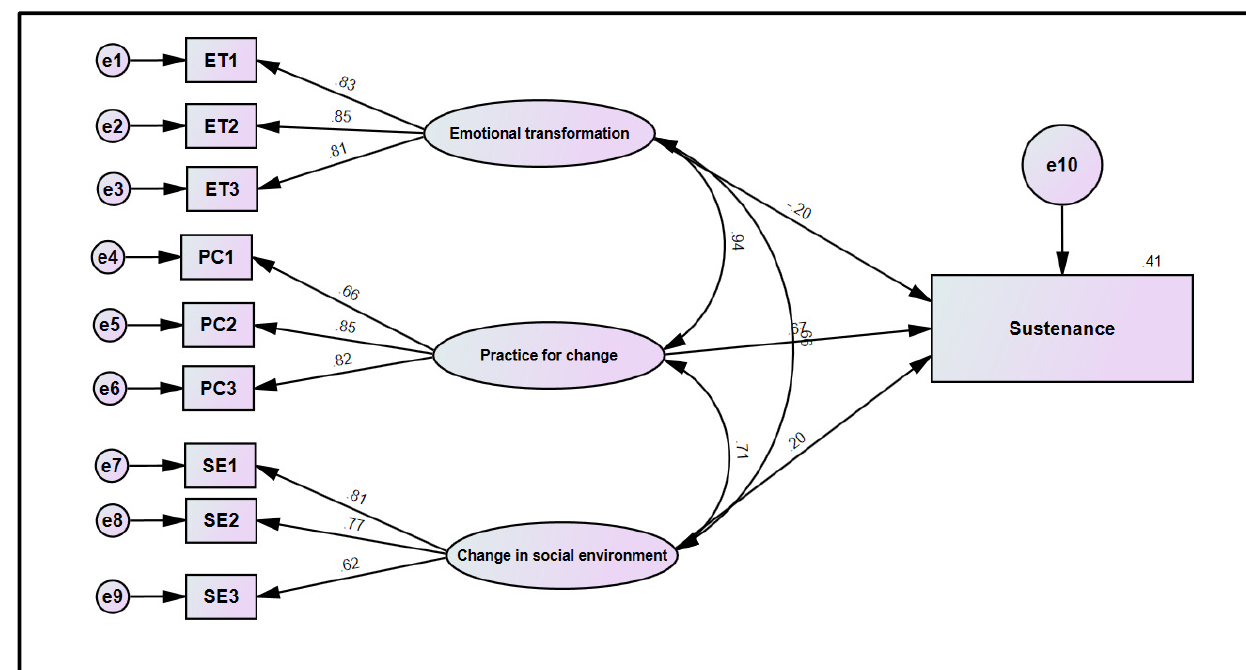
Figure 5. Structural model for sustaining vaping quitting behavior. Figure description: The standardized loadings in this model are correlations between the indicator or manifest variables (in boxes) and the latent factors (ovals). The double- headed arrows among the latent factors (ovals) represent correlations. The double-headed arrows between error terms represent correlations among the errors. ET1-ET3, PC1-PC3, and SE1-SE3 represent 3 items each of the “Emotional transformation,” “Practice for Change,” and “Changes in the Social Environment”, respectively.